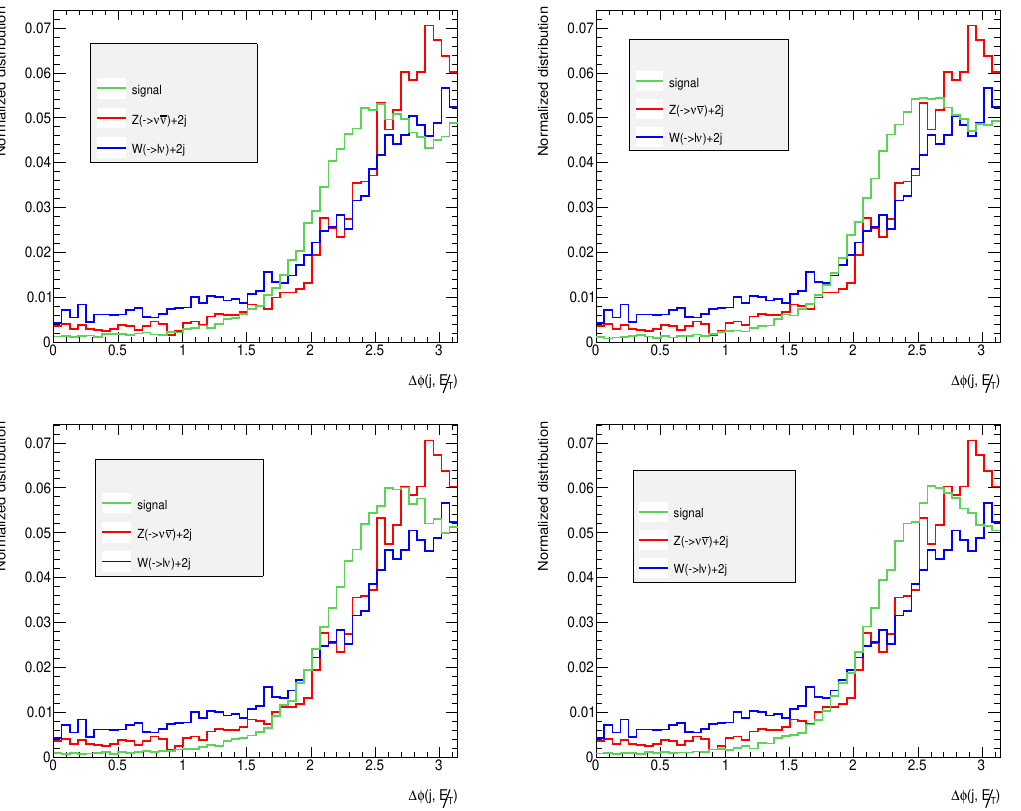
Figure 15 . (cid:1) (cid:30) ( =E T ; p jet ) distribution between the two forward jets for vector boson fusion signal T and background processes, Type I BP I(top left), Type I BP II(top right), Type II BP I(bottom left) and Type II BP II(bottom